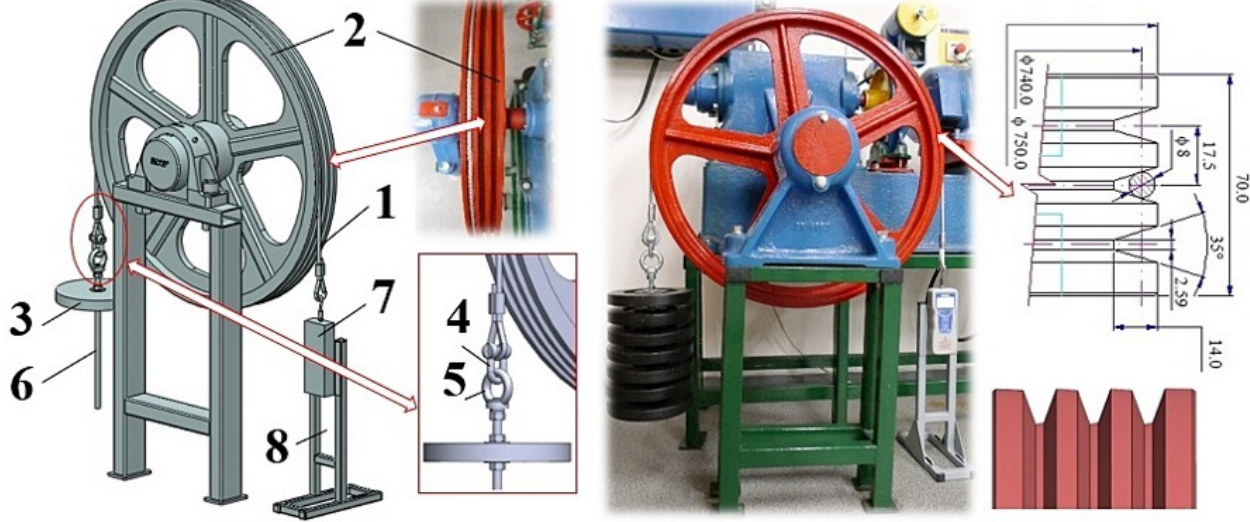
Figure 2. Experimental apparatus used to determine the coefficient of friction in the pulley V-groove. Fork 4 (according to DIN 82101—FORM A) is screwed onto the loop with eyelet strength min. 1770 MPa), length 1.6 m, clamped with sleeves (according to EN 13411-3).